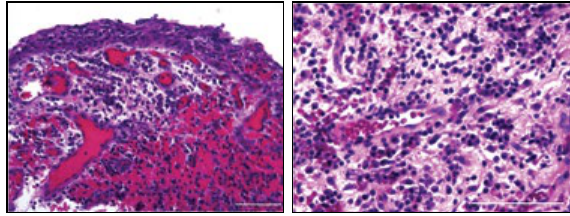
Figure 5. Histopathological examination findings (H&E staining). a: a cyst wall constituted by non-keratinized squamous epithelium surrounded by fibrous connective tissue (×100, scale: 50 µm). b: chronic inflammation with lymphocytes and plasma cells was observed in fibrous connective tissue (×200, scale: 50